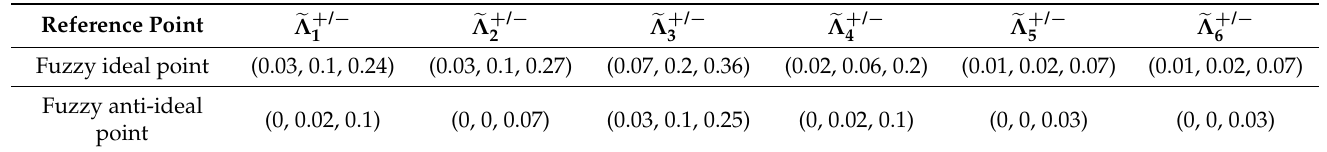
Table A3. Fuzzy ideal point and fuzzy anti-ideal point.